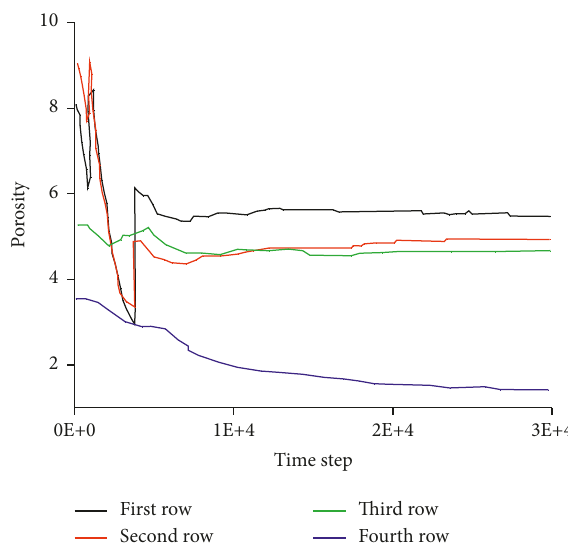
Figure 21: The porosity of the lower soil particles change with increased